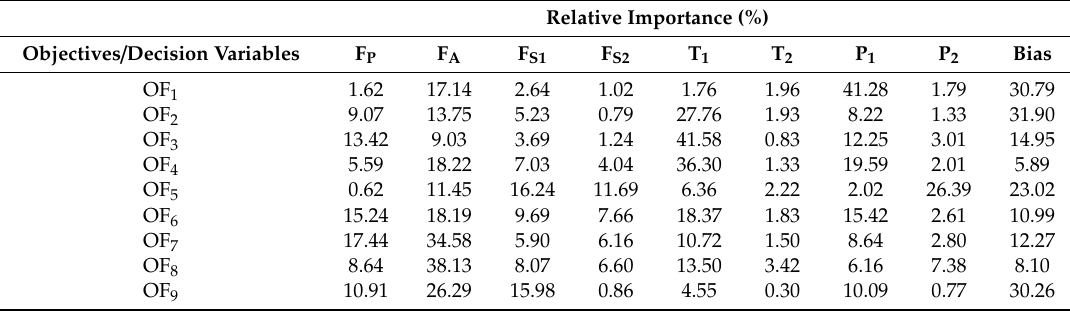
Table 3. Relative importance of the input variables on the objective functions in the selected ANN according to the modified Garson